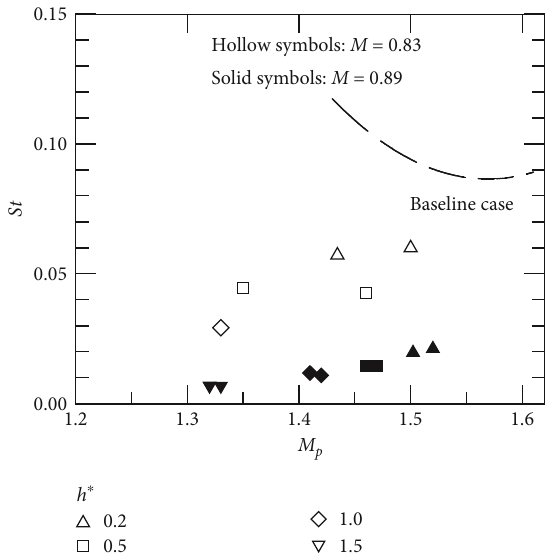
Figure 13: St versus peak Mach